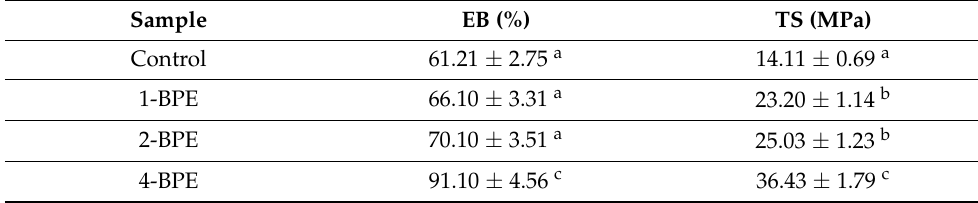
Table 1. Mechanical characterization of films.